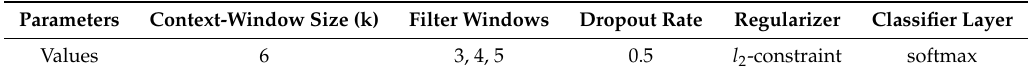
Table 13. Hyper-parameters settings for Author Model [16].